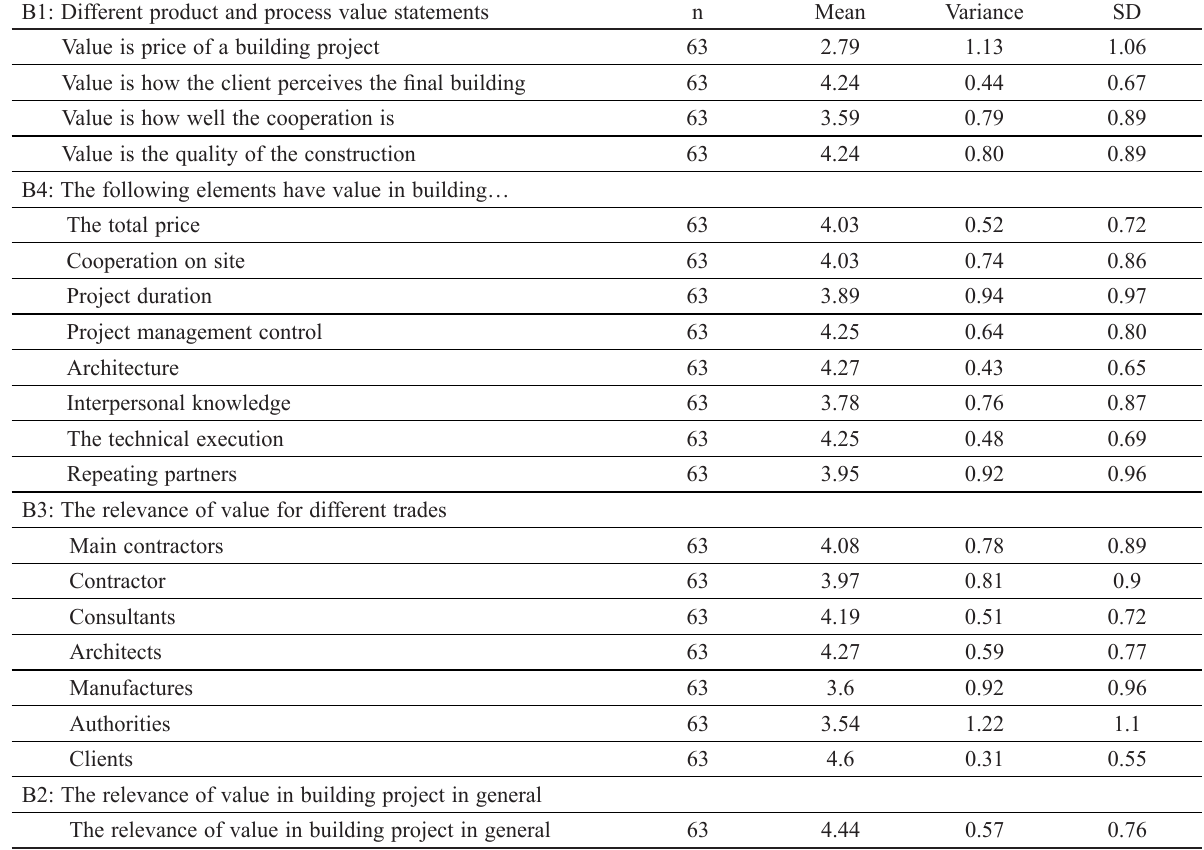
Table 5. Initial analysis of the variables concerning the perception of value B1: Different product and process value